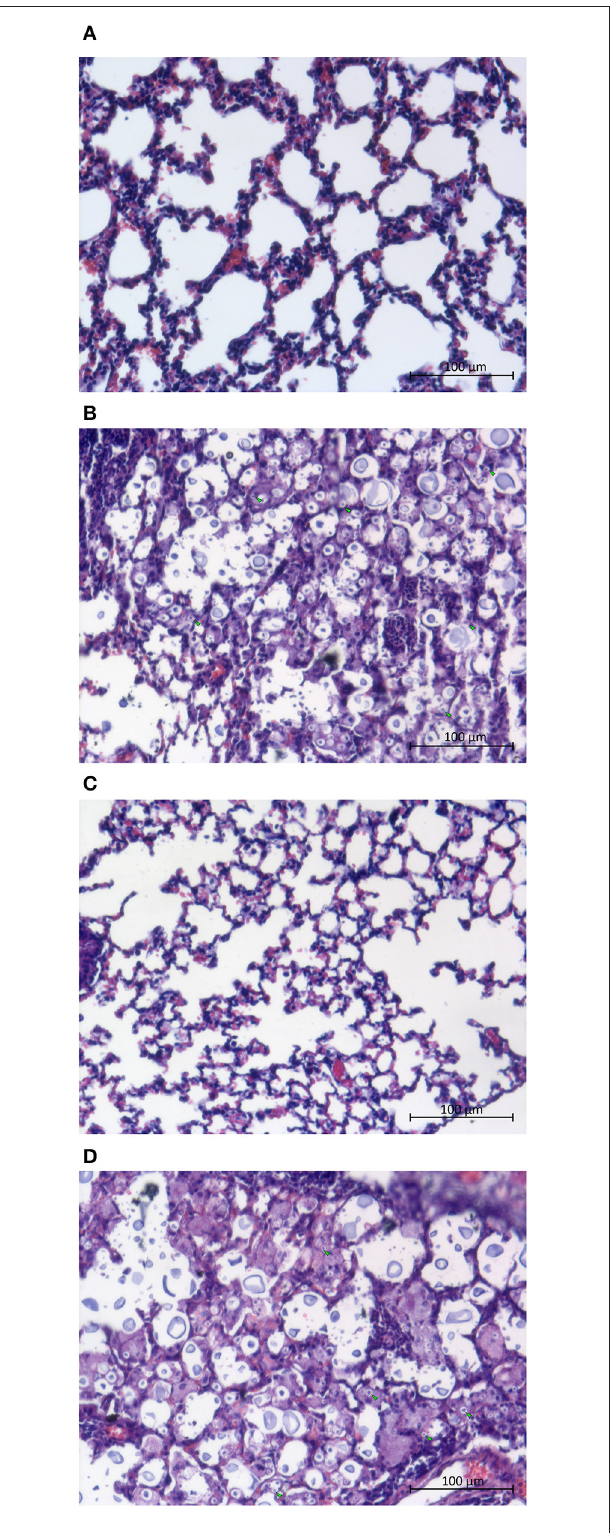
FIGURE 6 | The rcv1 ∆ strain does not cause damage to the lungs. Mice were infected as in Figure 5 (4–5 individuals per group) and lungs were harvested at day seven. (A) Normal lung. (B) H99 infection. (C) rcv1 ∆ infection. (D) rcv1 + RCV1 infection. HE staining, bright field. Green arrowheads, five randomly selected yeast cells per field in (A,C) , for illustration.